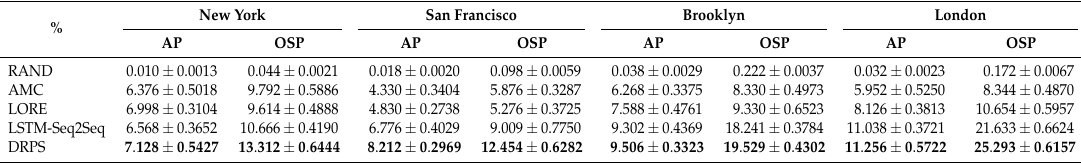
Table 7. Performance comparison in a cold-start scenario. The numbers in bold face indicate the ones with the best